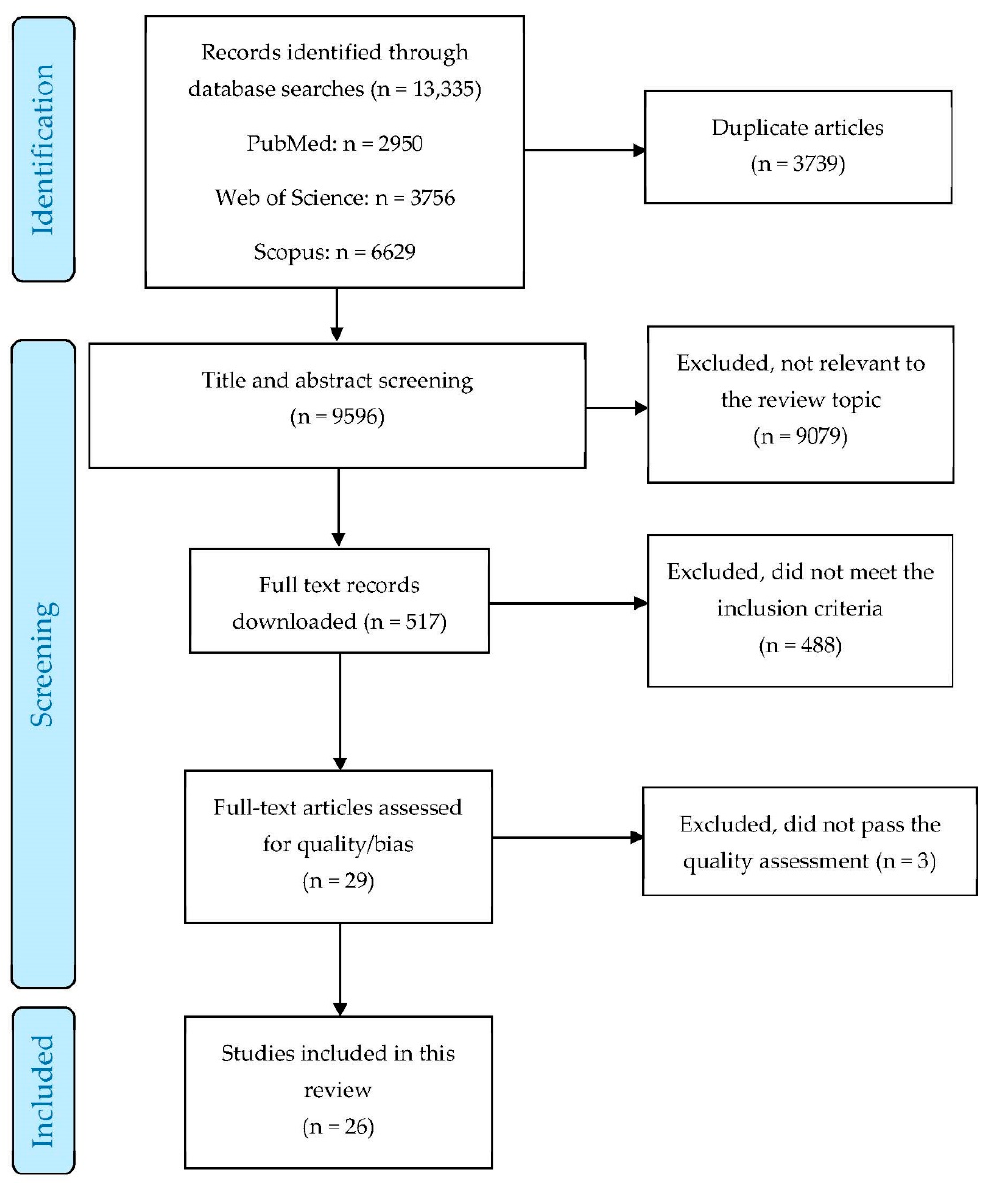
Figure 1. PRISMA flowchart presenting the search results and selection process of articles.